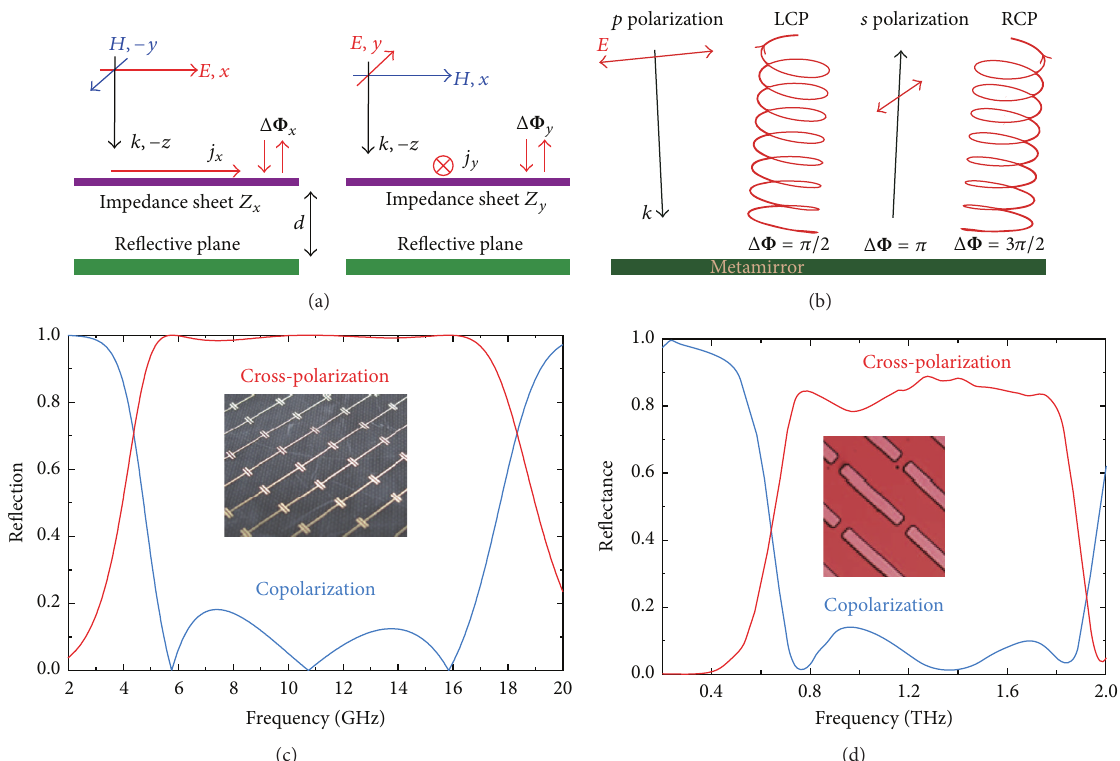
Figure9:(a)Schematicoftheanisotropicmetamirrorin 𝑥 -and 𝑦 -directions.(b)Schematicofpolarizationtransformationfora 𝑝 polarization incident wave. (c) Reflection coefficients for copolarized and cross-polarized components. Inset is the photograph of the fabricated sample, which is comprised of I-shaped resonators. (d) Reflectance of copolarization and cross-polarization for dipole array. Figures are reproduced from (a)–(c) [81] and (d)